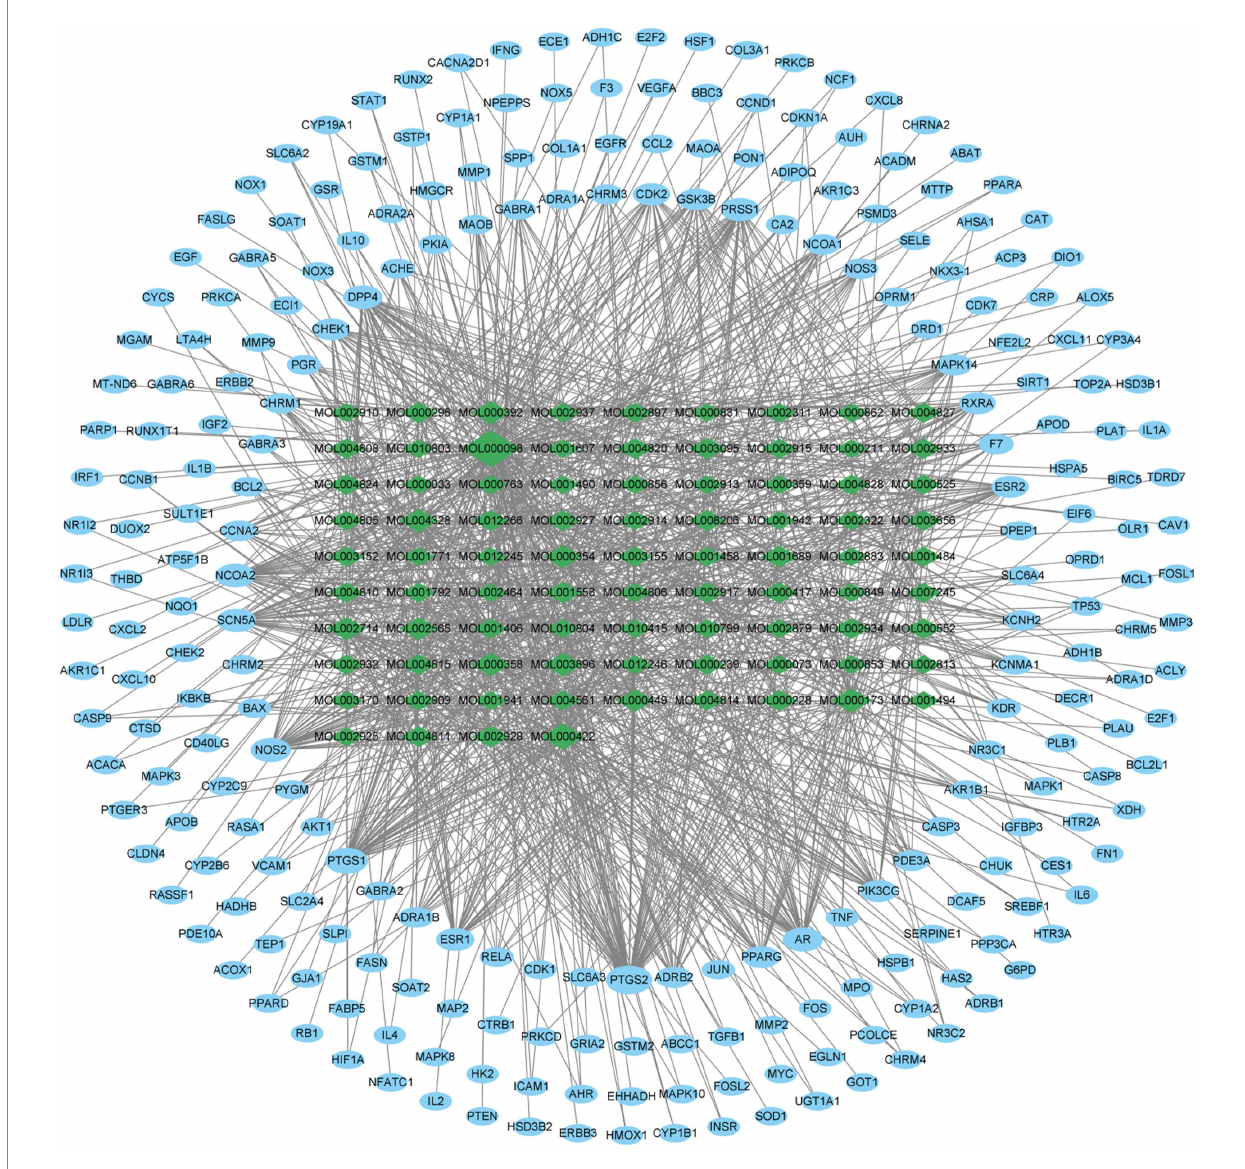
FIGURE 2 Drug components–target network. The green ovals correspond to the compositions, while the blue ovals refer to the targets. The more lines connected, the stronger the